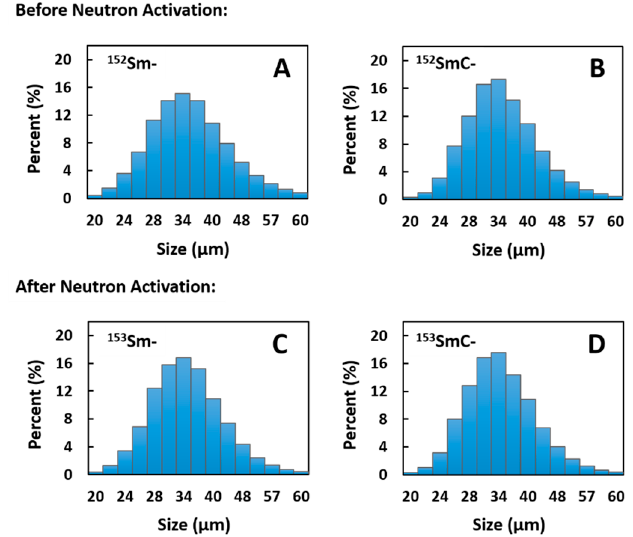
Figure 5. Particle size distribution of the Sm- and SmC-labeled microspheres both before ( A , B ) and after ( C , D ) 6 h neutron activation.